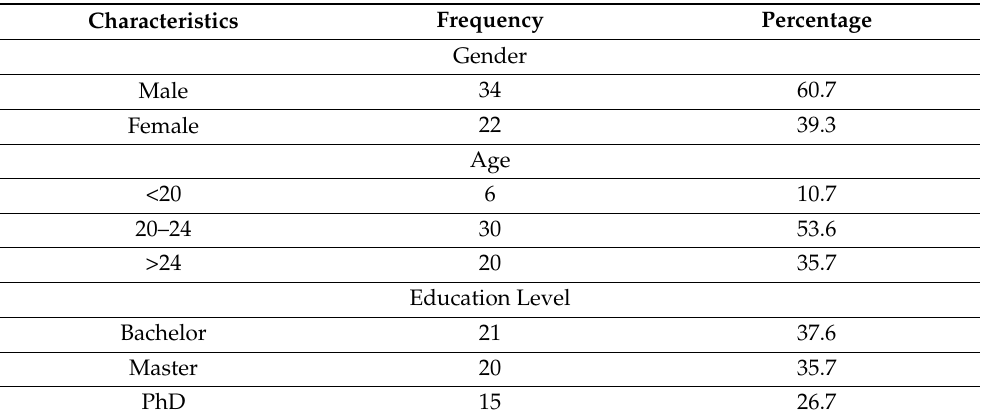
Table 4. Background information of study participants ( n = 56).